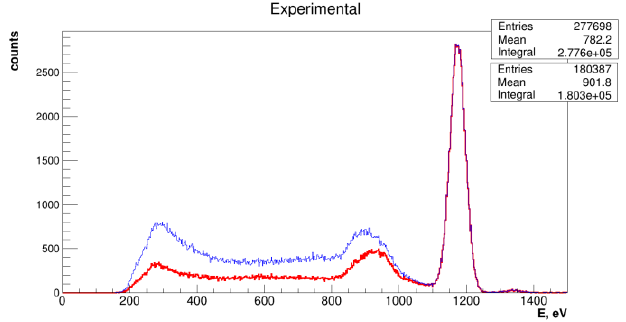
Fig. 5. Compton suppression effect of NaI(Tl) of the own detector and surrounding detectors for central detector of 3x3 detector